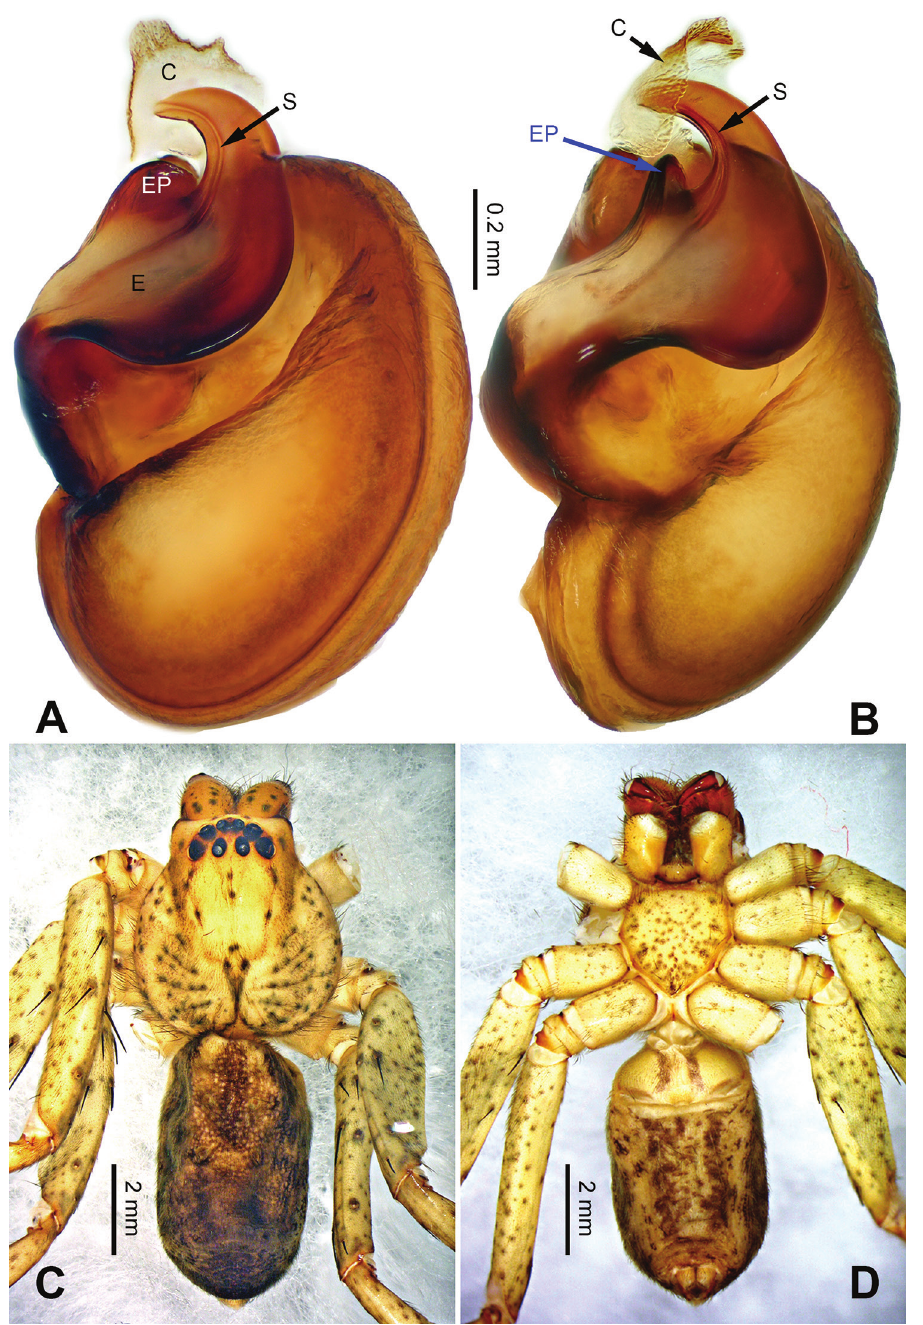
Figure 17. Pseudopoda nyingchiensis Zhao & Li, sp. n., male holotype. Right bulb horizontally flipped for the sake of comparison. A Bulb, ventral view B Bulb, dorsal view C Habitus, dorsal view D Habitus, ventral view. Scale bar equal for A, B